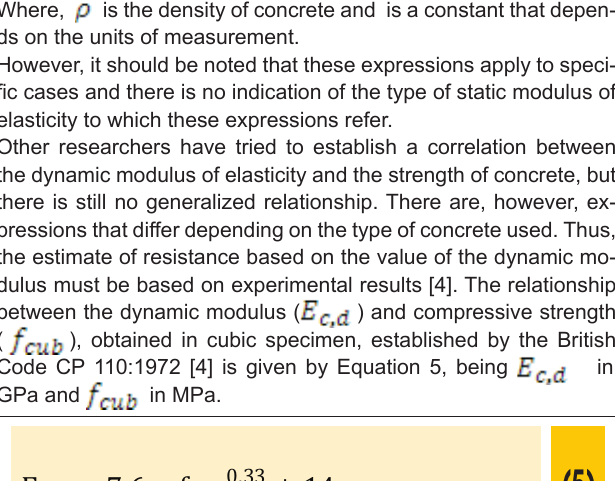
Figure 4 – Relationship between static and dynamic modulus of concretes with different strengths.